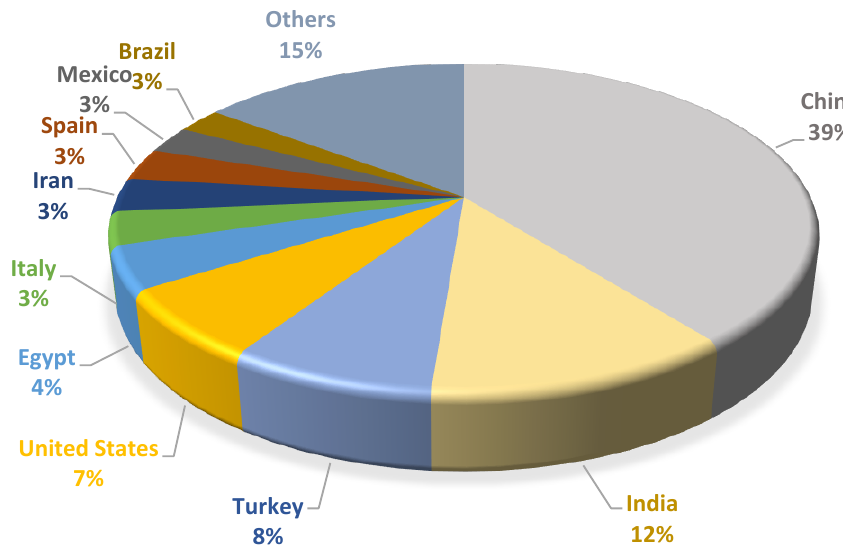
Figure 1. Top ten countries for tomato production based on FAOSTAT (2019) [8].